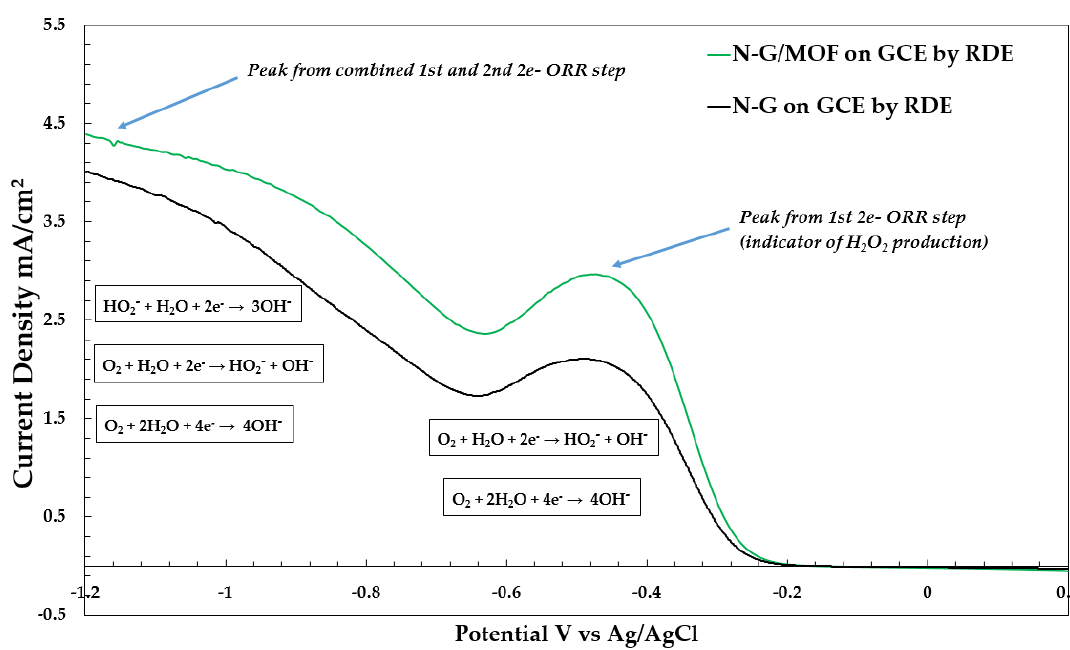
Figure 1. LSV plot for ORR in the oxygen saturated 0.1 KOH electrolyte on the N-G/MOF (green line) and N-G (black line) catalysts coated GCE working electrode.